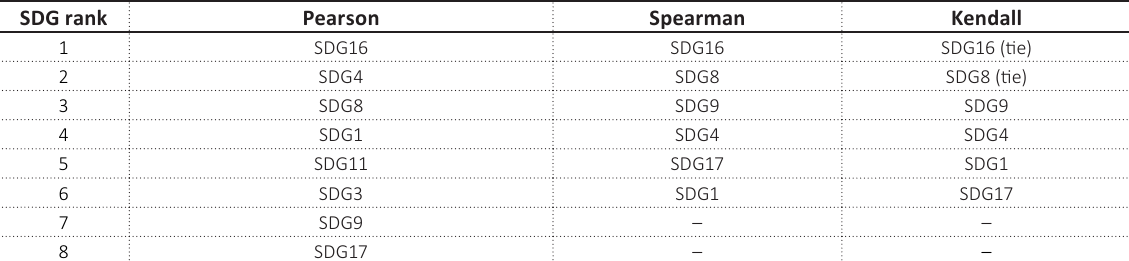
Table 8. SDG ranking according to the strength of association between FinTech PEST environment scores and SDG scores